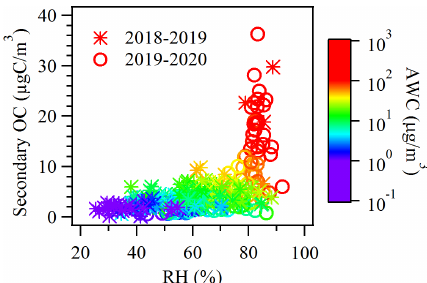
Figure 3. Dependence of secondary OC (OC sec ) on RH among the two campaigns, color-coded by AWC levels. Results from the 2018–2019 campaign and 2019–2020 campaign were marked using stars and circles, respectively. A majority of the data points with RH above 80% were observed during 2019–2020. RH exceeded 80% for only 10 samples collected during 2018–2019, and only 3 out of these 10 samples showed an RH-dependent increase of OC sec